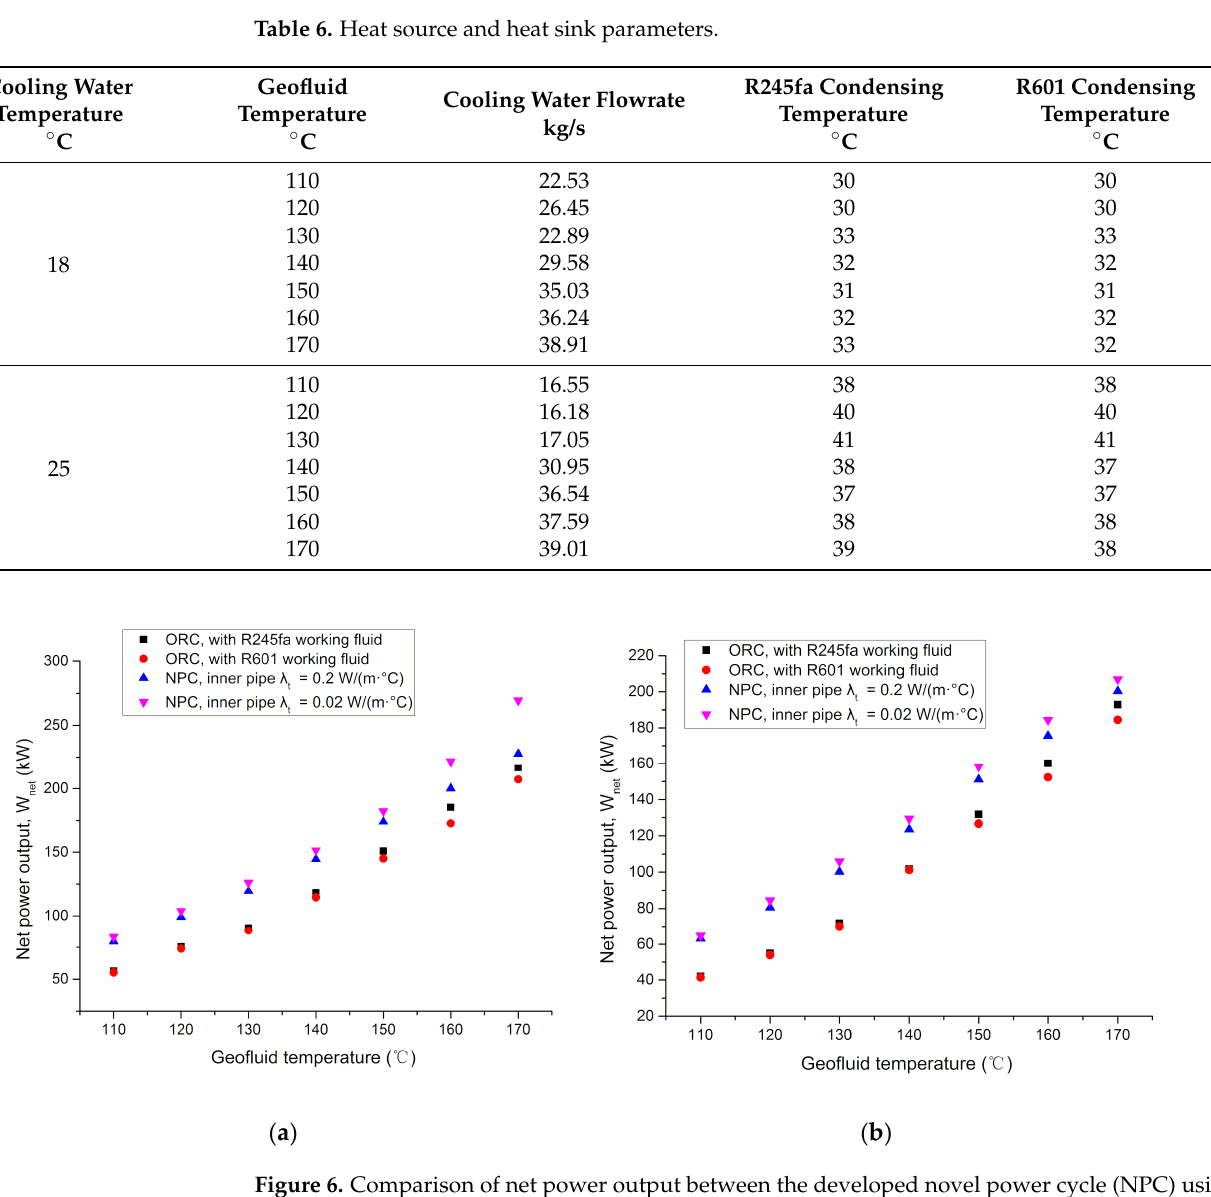
Figure 6. Comparison of net power output between the developed novel power cycle (NPC) using R32/CO 2 as working fluid and conventional ORC using R245fa or R601 as working fluid respectively, with two thermal conductivities, 0.2 W/(m·°C) and 0.02 W/(m·°C), of the DHE inner pipe being considered (geofluid mass flowrate = 5 kg/s, DHE length = 300 m). ( a ) Cooling water temperature is 18 °C. ( b ) Cooling water temperature is 25 °C.